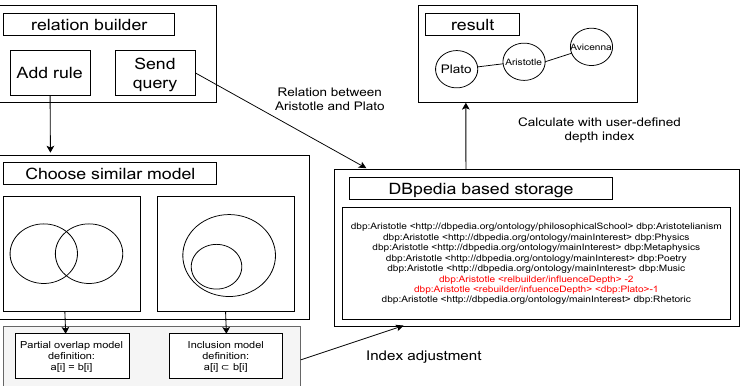
Figure 7. Entire system